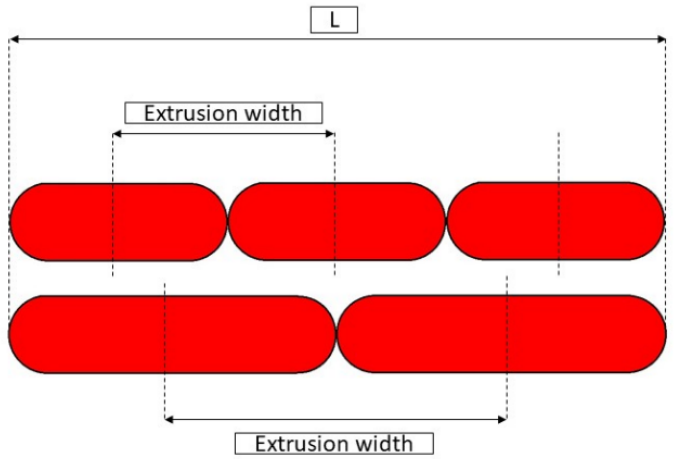
Figure 9. Lower extrusion width (on top) and higher extrusion width (on bottom) compared for a given dimension L.